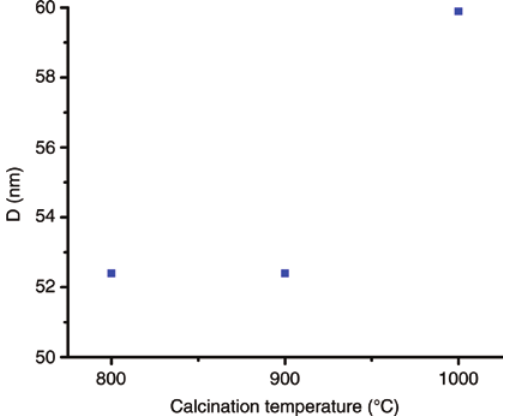
Figure 2: Crystallite size of the eggshell calcined at 800 ° C, 900 ° C and 1000 °